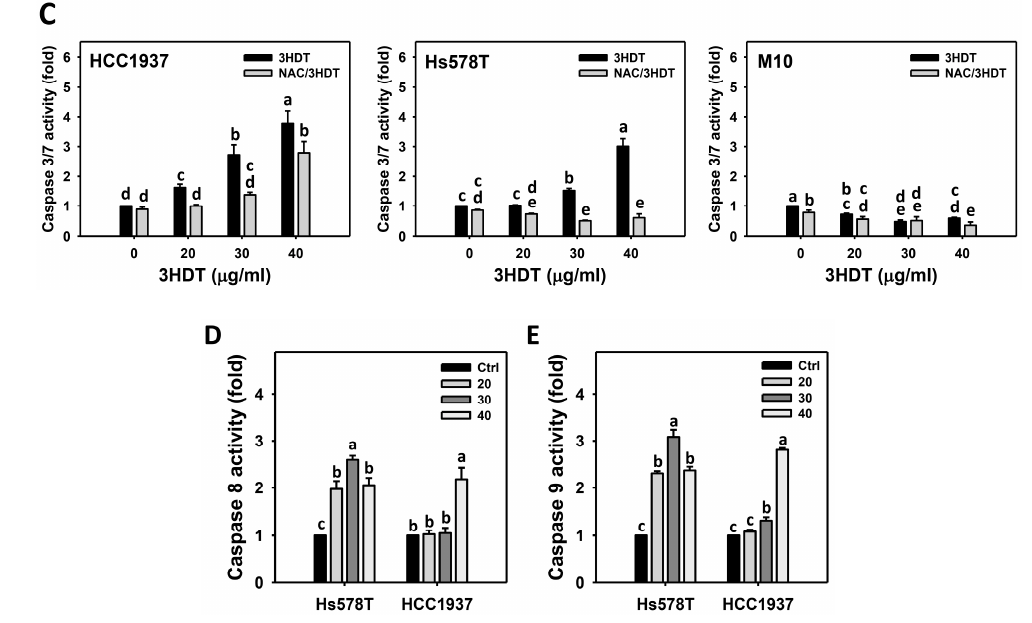
Figure 4. Caspase 3/8/9 status of 3HDT treatment. ( A ) Caspase 3 flow cytometry assay of 3HDT (control, 20, 30, and 40 μ g/mL) for 24 h. (+) is marked as caspase 3 (+), which indicates the proportion with high caspase 3 level, while ( − ) indicates the proportion with low caspase 3 level. ( B ) Caspase 3 flow cytometry assay of NAC/3HDT. 3HDT and NAC/3HDT indicate 12 or 24 h 3HDT treatment (40 μ g/mL) without and with NAC pretreatment, respectively. ( C ) Caspase 3/7 luminescence assay of NAC/3HDT for 24 h. 3HDT (control, 20, 30, and 40 μ g/mL) was posttreated after NAC pretreatment. ( D,E ) Caspase 8 and caspase 9 luminescence assay of 3HDT (control, 20, 30, and 40 μ g/mL) for 24 h. Data: mean ± SD ( n = 3). Treatments differ significantly for multiple comparisons when the letters are not overlapping ( p < 0.05).